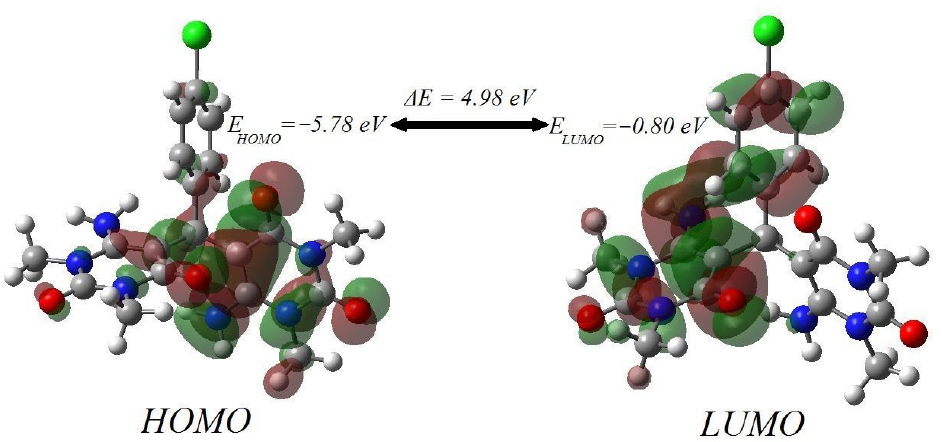
Figure 3. The pattern of HOMO and LUMO frontier molecular orbital surfaces.